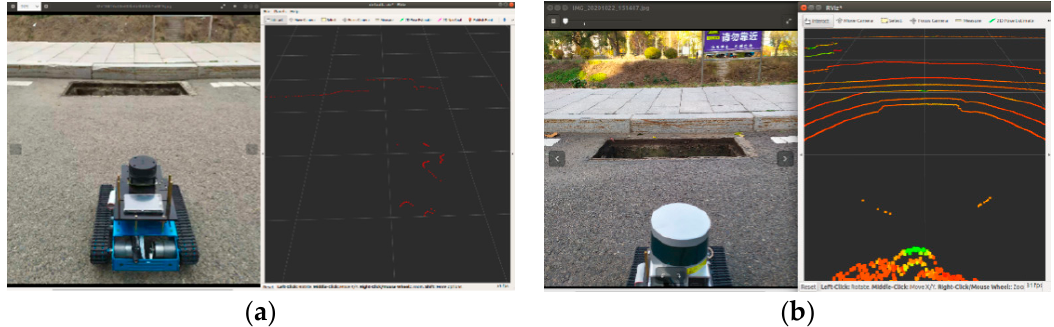
Figure 20. Performance comparison of single-line LiDAR and 16-line LiDAR. ( a ) Single line LiDAR detects negative obstacle; ( b ) 16-line LiDAR detects negative obstacle.